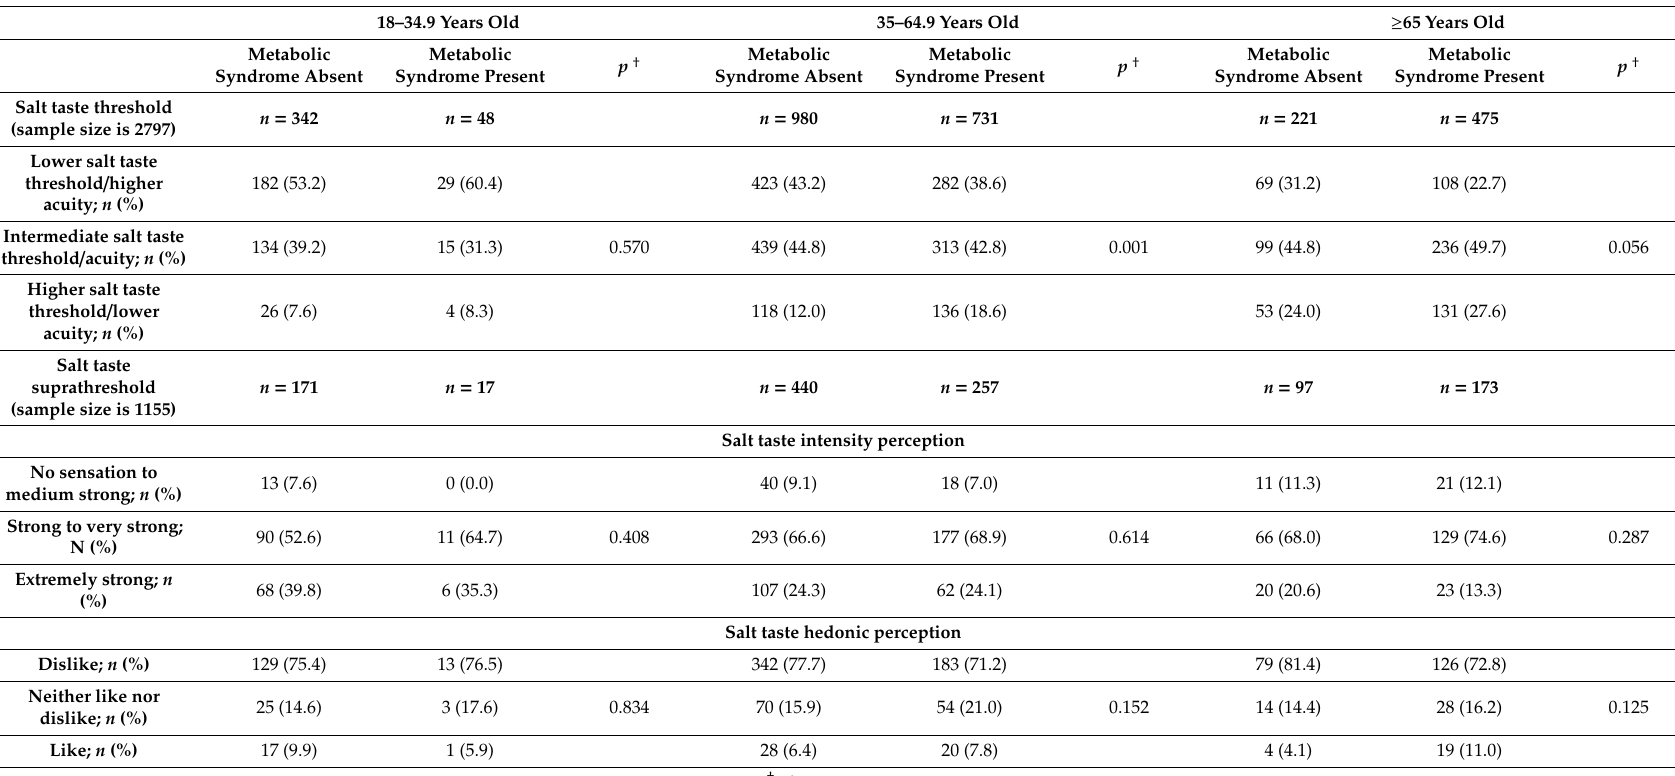
Table A2. Salt taste threshold and suprathreshold perception according to the presence or absence of the metabolic syndrome, stratified by age